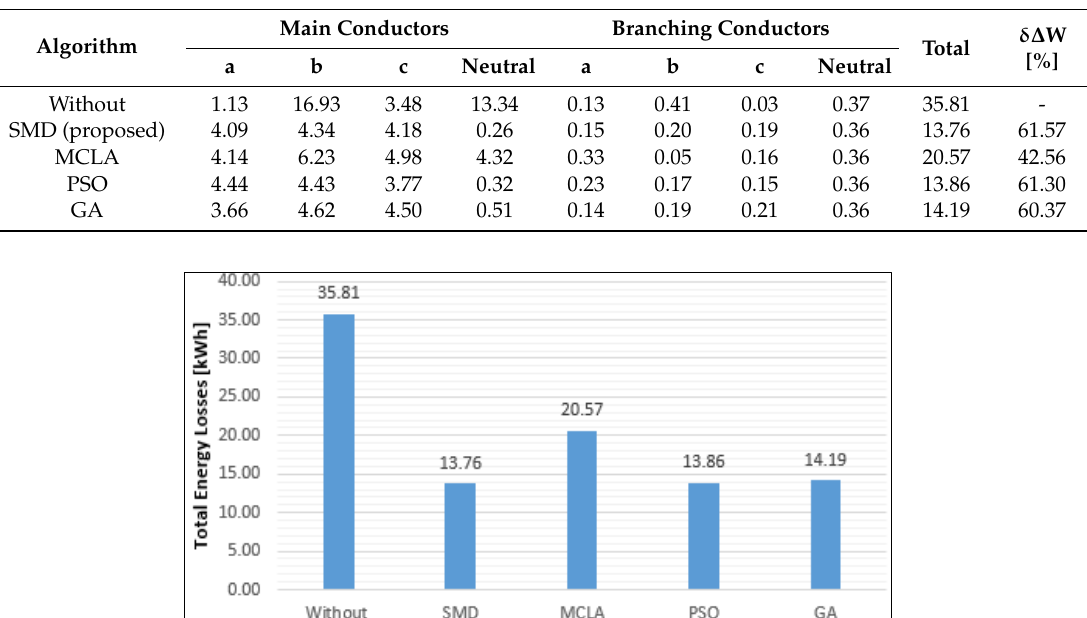
Table 12. Comparison between the energy losses calculated with different algorithms, [kWh].